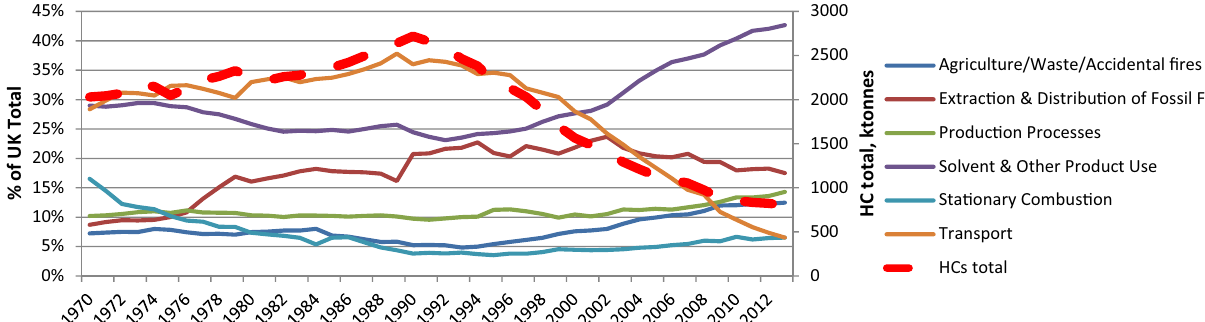
Fig. 2 HC emissions by sector, UK, 1970 – 2013. Six sectors in percent, left-hand Yaxis. HC total in kilotonnes, right-hand Yaxis. Sector definitions are not exactly the same as those in the subsequent table, so figures are somewhat different, but still representative. (Source: NAEI)